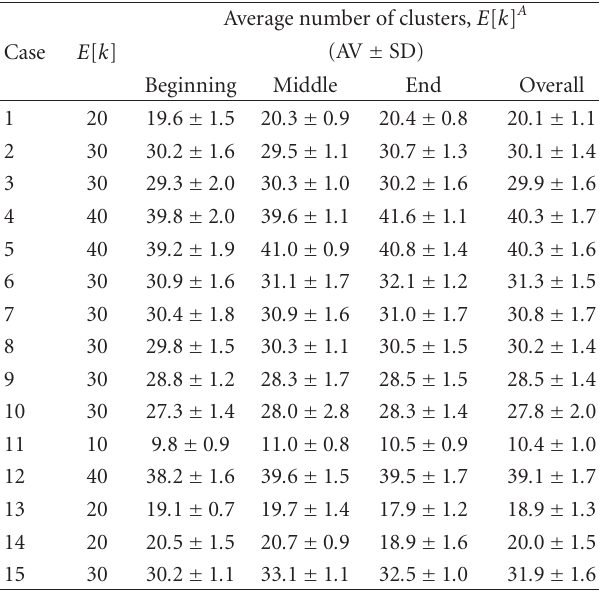
Table 4: Comparison of expected and actual number of clusters of EDCR algorithm.